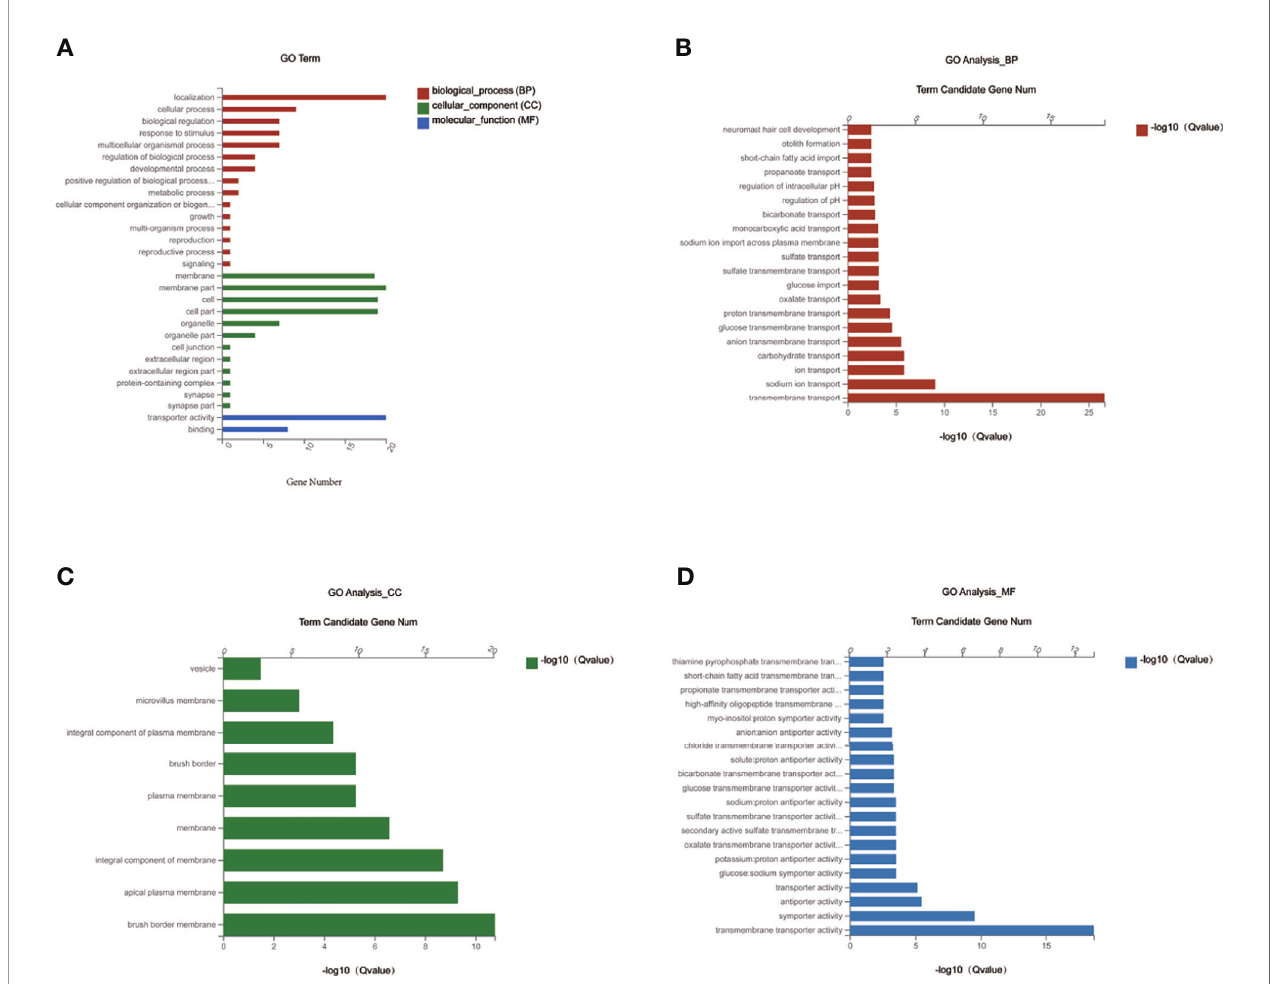
FIGURE 5 | GO enrichment analysis of MET-responsive Slc genes in liver. (A) The annotation and classi fi cation of GO functional enrichment analysis with the common DEGs of Slc transporters in the liver. The functional enriched classes of the common DEGs of Slc transporters in the liver annotated by biological processes